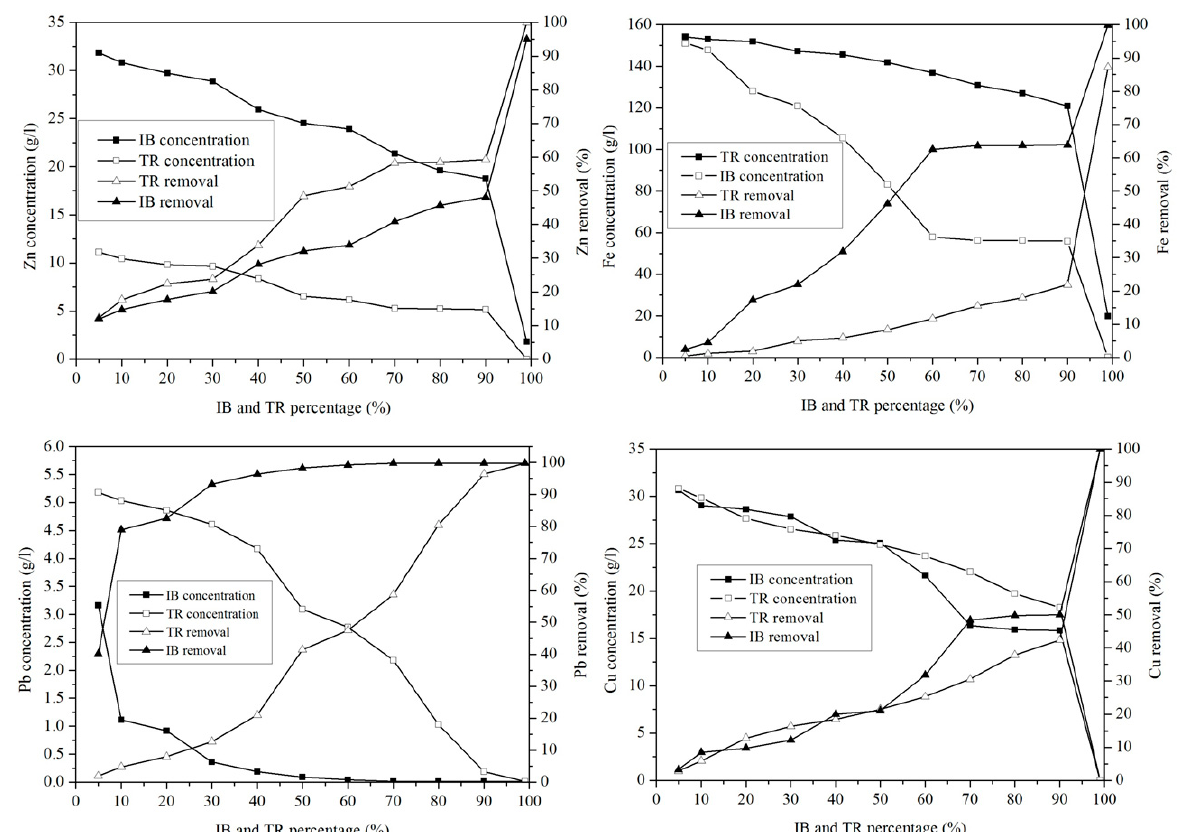
Figure 11. Concentration of and variation in heavy metals.